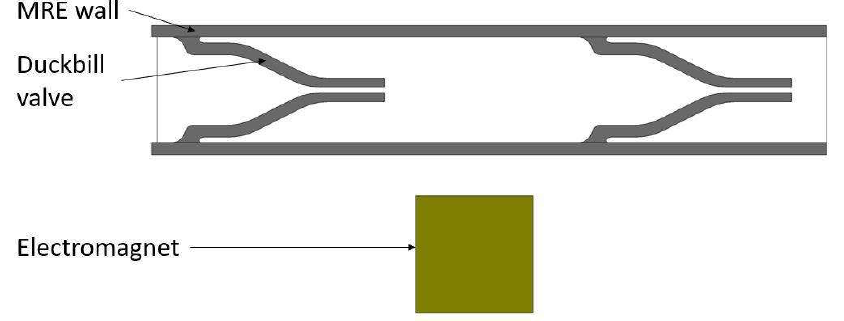
Figure 1. The proposed micropump design with its main components.